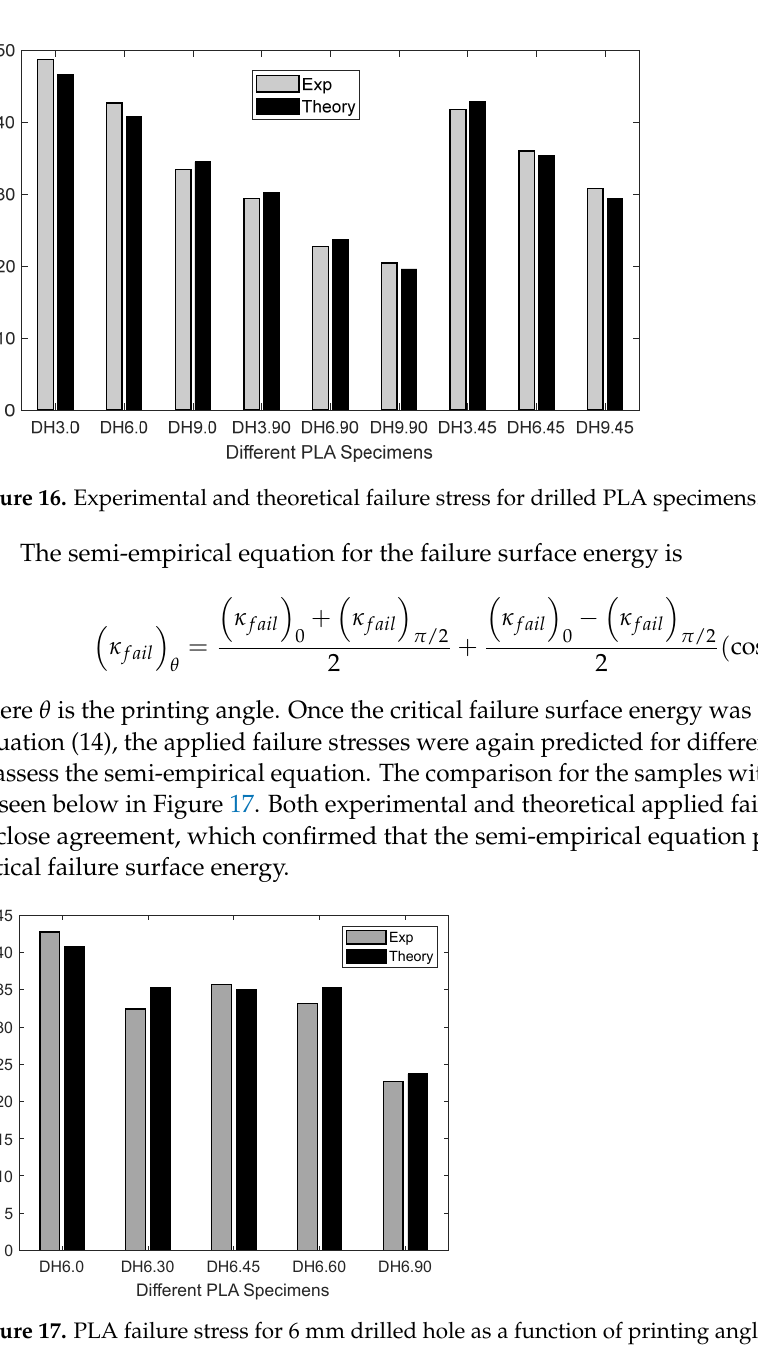
Figure 17. PLA failure stress for 6 mm drilled hole as a function of printing angle.